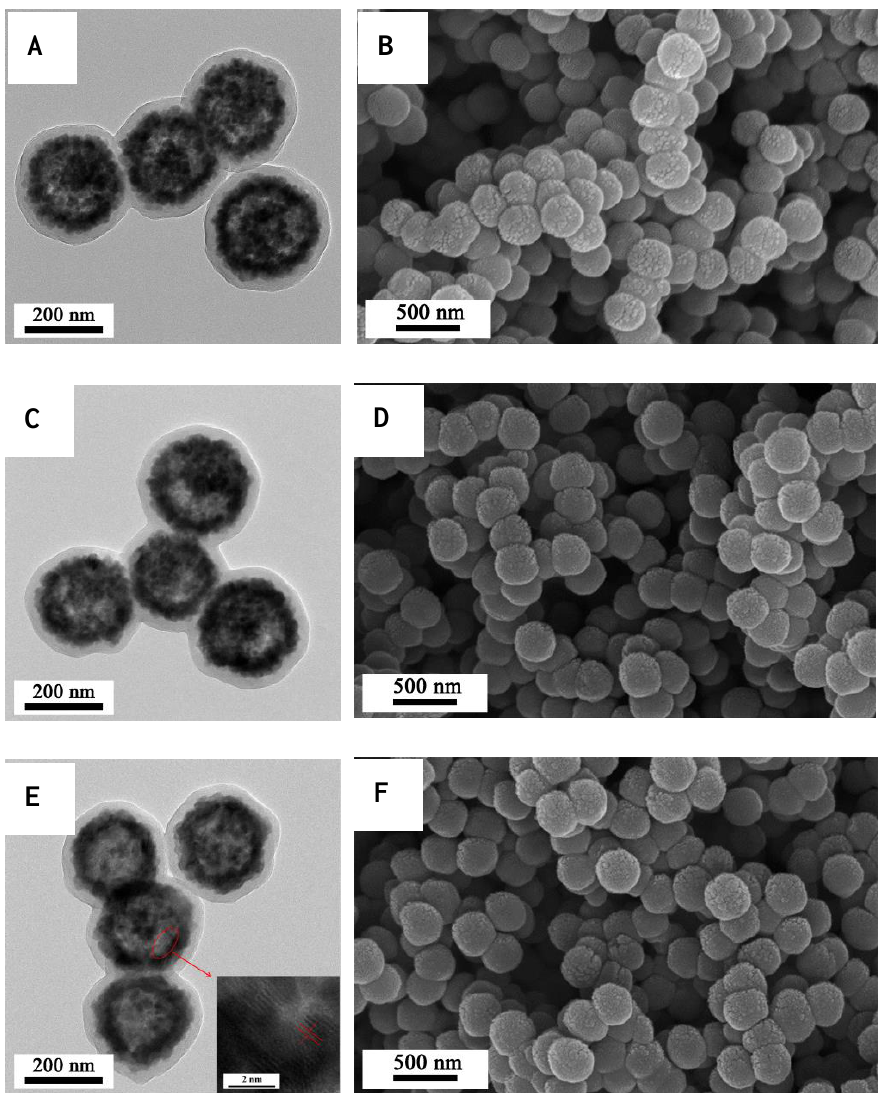
Figure 2. TEM and SEM images of samples prepared at different carbonation temperatures: Fe 3 O 4 @C-550 ( A , B ), Fe 3 O 4 @C-650 ( C , D ) and Fe 3 O 4 @C-700 ( E , F